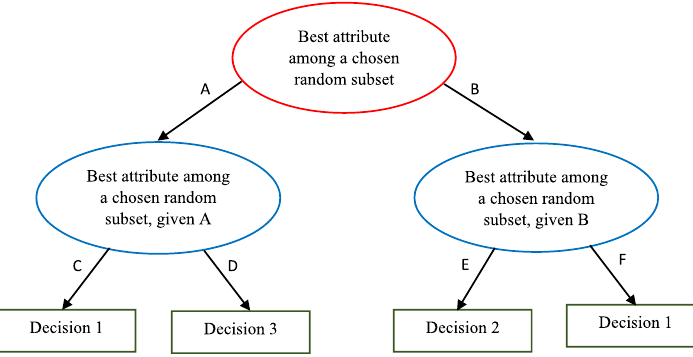
Fig. 6 Structure of Random